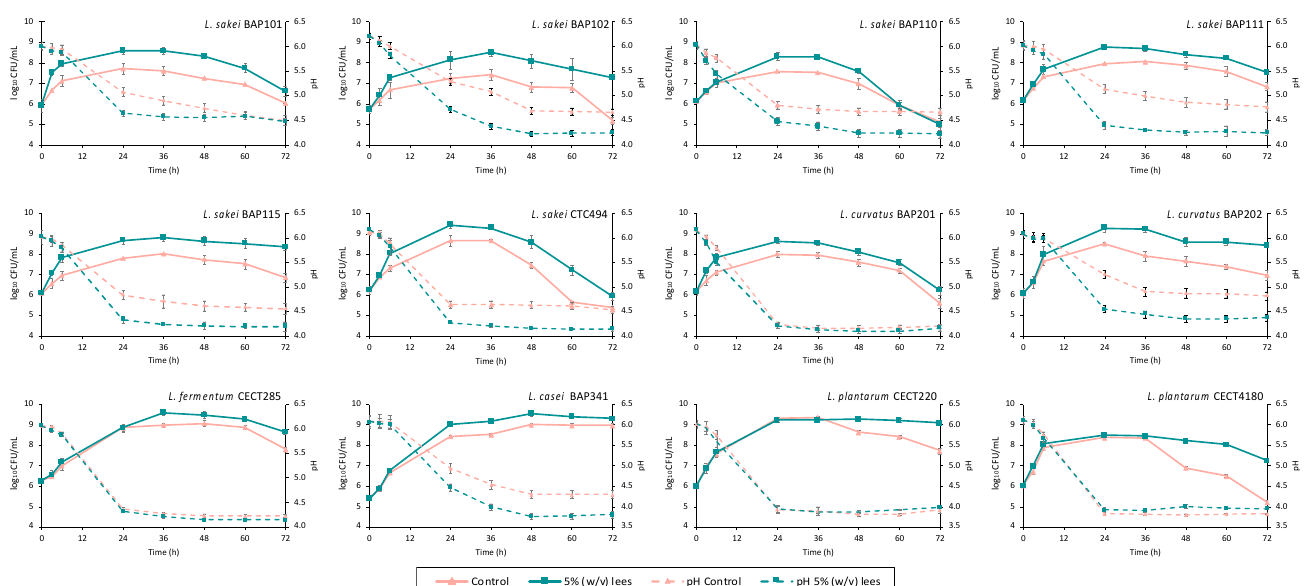
Figure 3. Growth kinetics and changes of pH values of LAB strains cultured without (control) and with 5% cava lees. The average and standard deviation of three independent experiments are shown. The enhanced bacterial growth in L. sakei strains cultured with cava lees also resulted in a greater decrease in pH in all strains (Figure 3). The increase in acidity of the culture media was significantly higher and faster during the first 24 h (pH values of 4.2–4.7, depending on the strain), coinciding with the exponential growth phase ( p < 0.05). The pH of the control culture medium (without cava lees) was always higher, with values of 4.7–5.3.